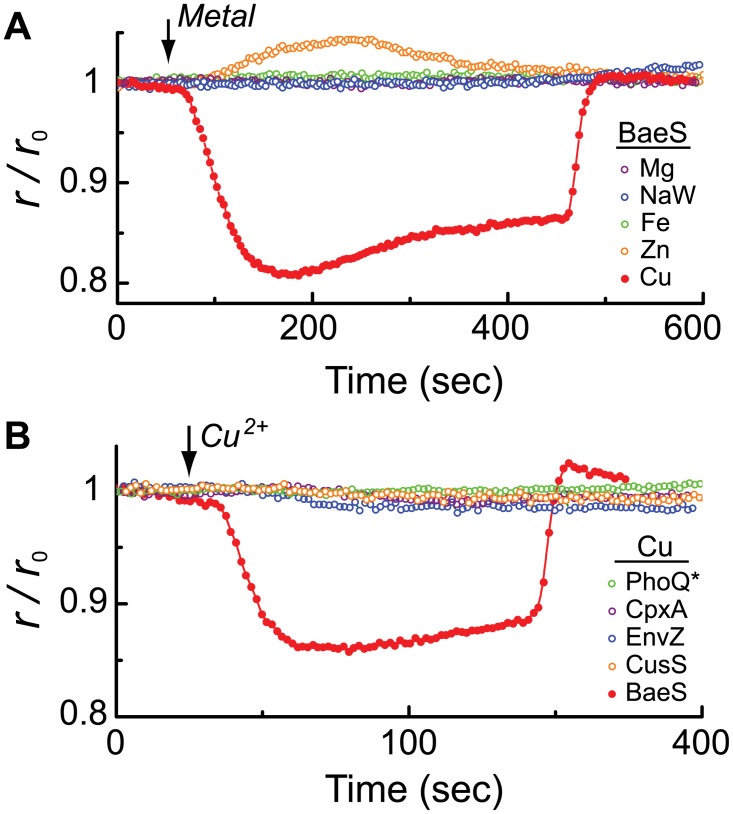
The specificity of the BaeS response to copper.(A) Fluorescence anisotropy traces measured from ΔbaeS cells expressing mYFP-tagged BaeS. MgCl2, Na2WO4, FeSO4, or ZnSO4 (10 μM) was added at the time indicated by the arrow and removed 200 seconds later. The response to 10 μM CuSO4 is shown for comparison. (B) Anisotropy responses of different mYFP-tagged sensory kinases to CuSO4 (10 μM). To avoid possible differences among deletion strains, all of the tagged sensors were tested in wild-type strain MG1655, in which all sensors are naturally expressed from the chromosome.